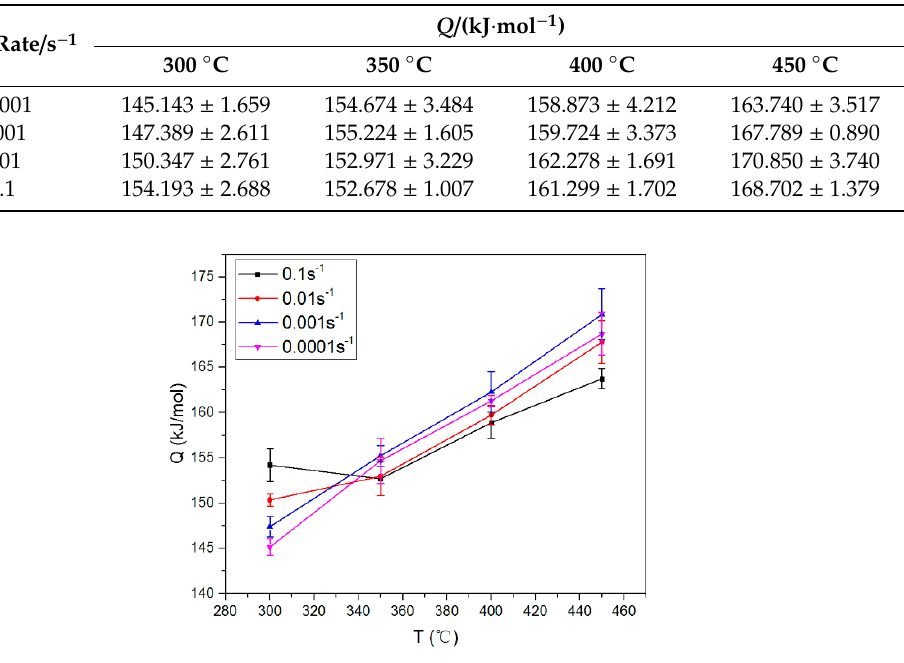
Figure 6. Relationship between deformation activation energy and temperature of nanohybrid/AZ80 composites at different strain rates. Table 2. Deformation activation energy of nanohybrid/AZ80 composite at different strain rates and deformation temperatures.